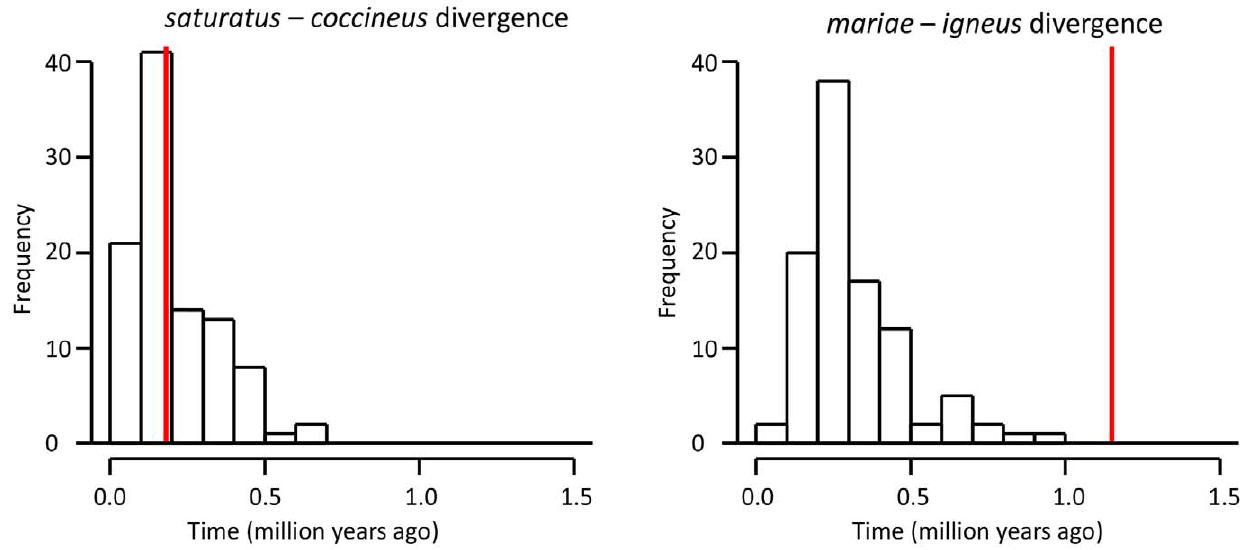
Figure 5. Coalescent simulations for island-mainland divergences. Simulated distributions of speciation times for island-mainland divergences: A) saturatus – coccineus divergence, and B) mariae – igneus divergence. Observed speciation times estimated from mtDNA for each divergence are plotted as vertical red lines.